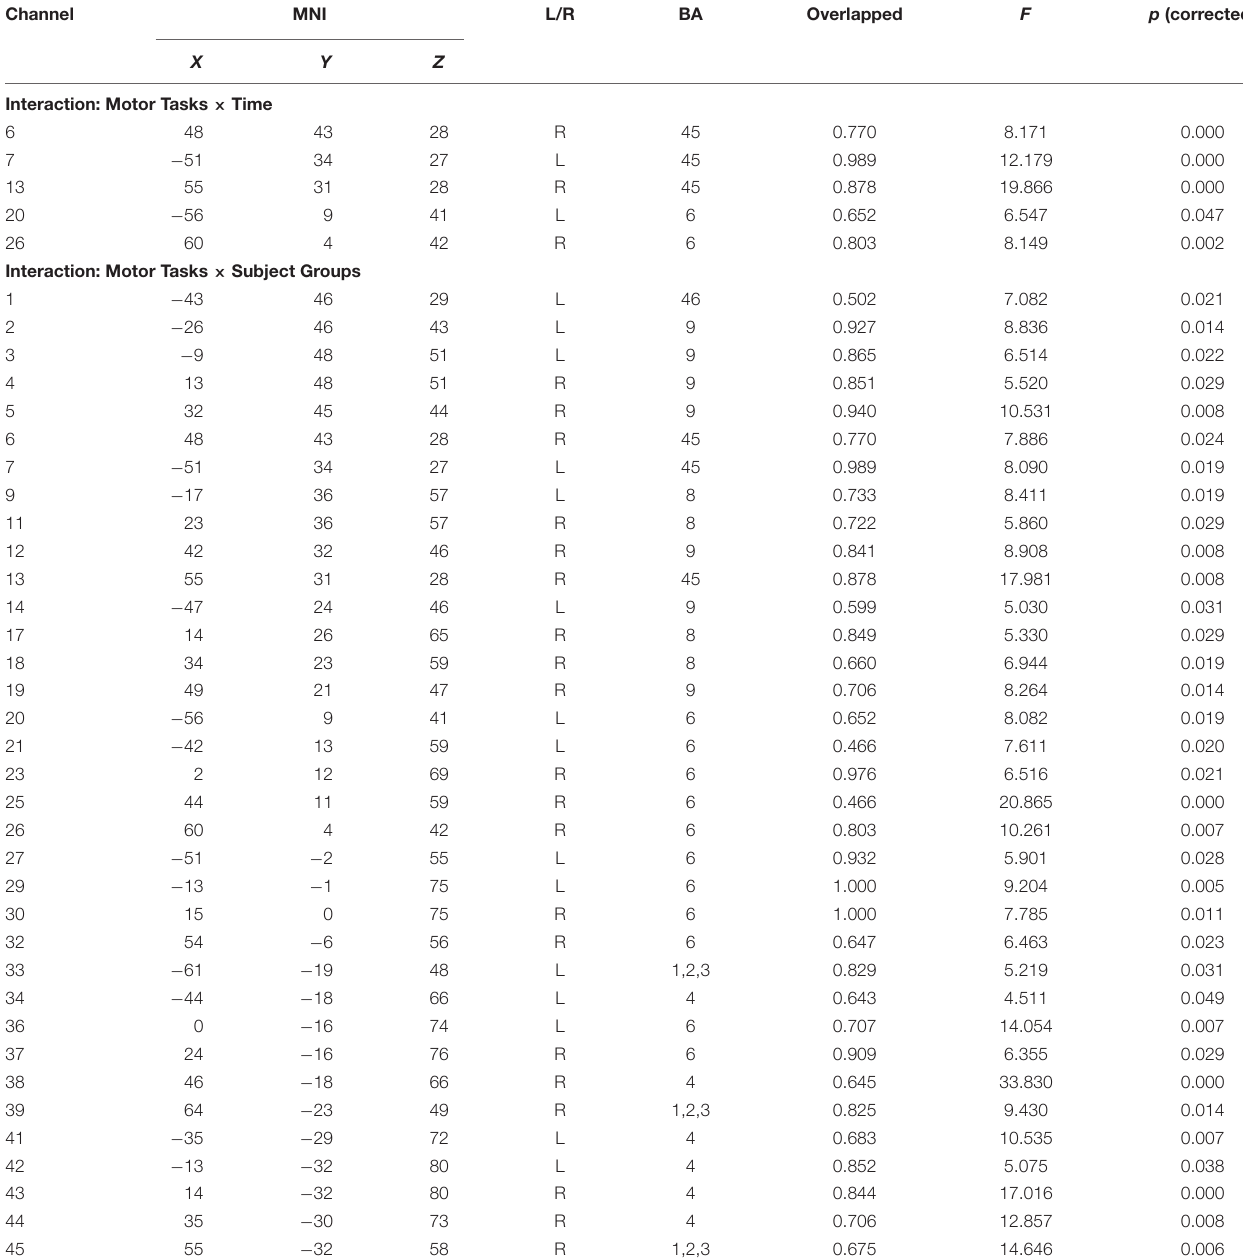
TABLE 1 | The interaction results of each channel under different experimental conditions.